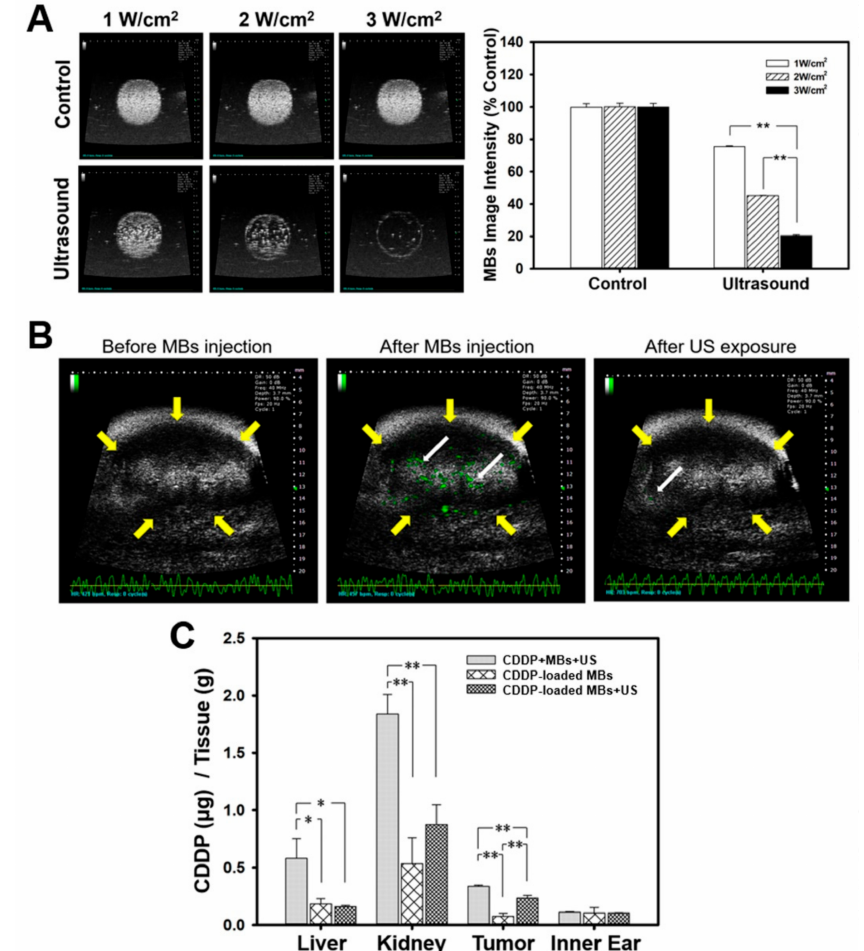
Figure 3. Influence of MBs and US on the in vivo CDDP accumulation. ( A ) High frequency US images of albumin MBs in tissue-mimicking agarose phantoms before (control) and after sonication at 1, 2, and 3 W/cm 2 for 30 s. The image intensities of MBs are quantified; ( B ) A series of high-frequency US images that focus on head and neck carcinoma tumor lesions (yellow arrows) showed the presence of MBs (green) within the tumor (white arrows) after their administration via the mouse tail vein, and the disappearance of MBs when after exposure to therapeutic US for 30 s; ( C ) The CDDP level in vital organs was determined 20 min after a single intravenous administration of chemotherapy using ICP-MS quantitative method. Values are expressed as mean ± SEM ( n = 5). * p < 0.05, ** p <